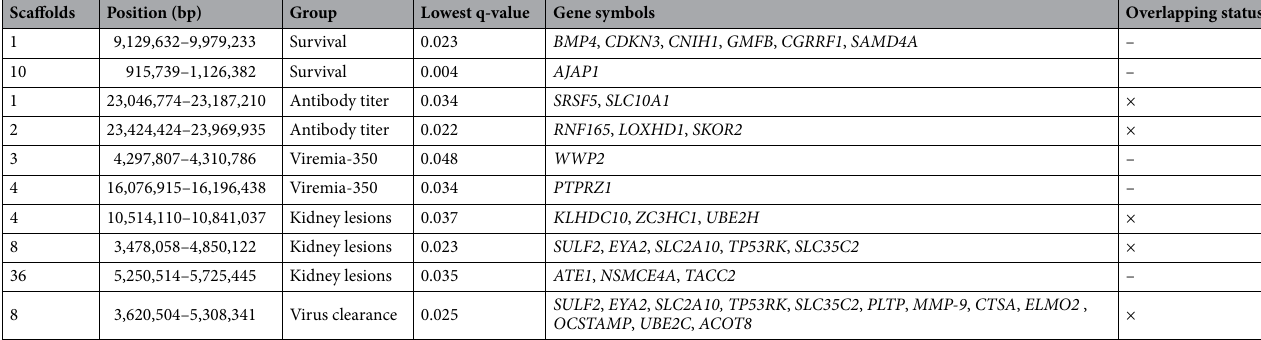
Table 4. Candidate regions identified by hapFLK test along with genes involving in these regions. a Overlaps with those regions detected by integrated measurement of F ST and θ π